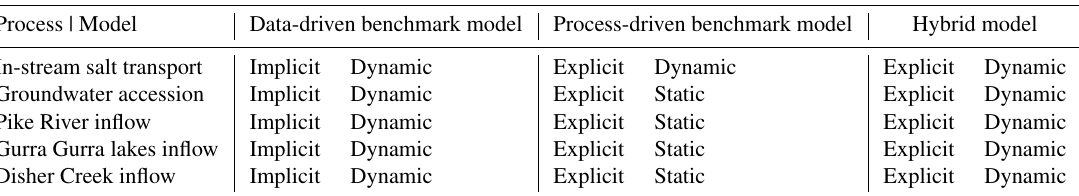
Table 3. Method by which different processes are represented by the hybrid and benchmark data- and process-driven models. The inputs are represented either explicitly (by separate processes within the model) or implicitly. The outputs are either dynamic (the salt load varies in response to some time-dependent environmental changes) or static.